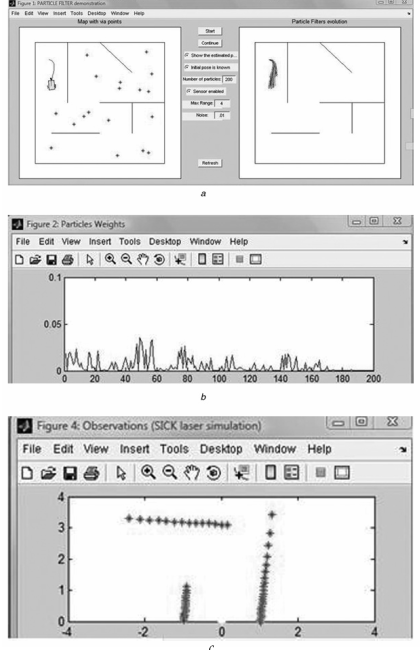
Figure 4. An example of particle filtering simultaneous localization and mapping (SLAM) in simula- tion [49]. ( a ) The true position and the estimated particles of a simulated robot in a maze. ( b ) The weights of distribution of particles. ( c ) The sensor information from a laser